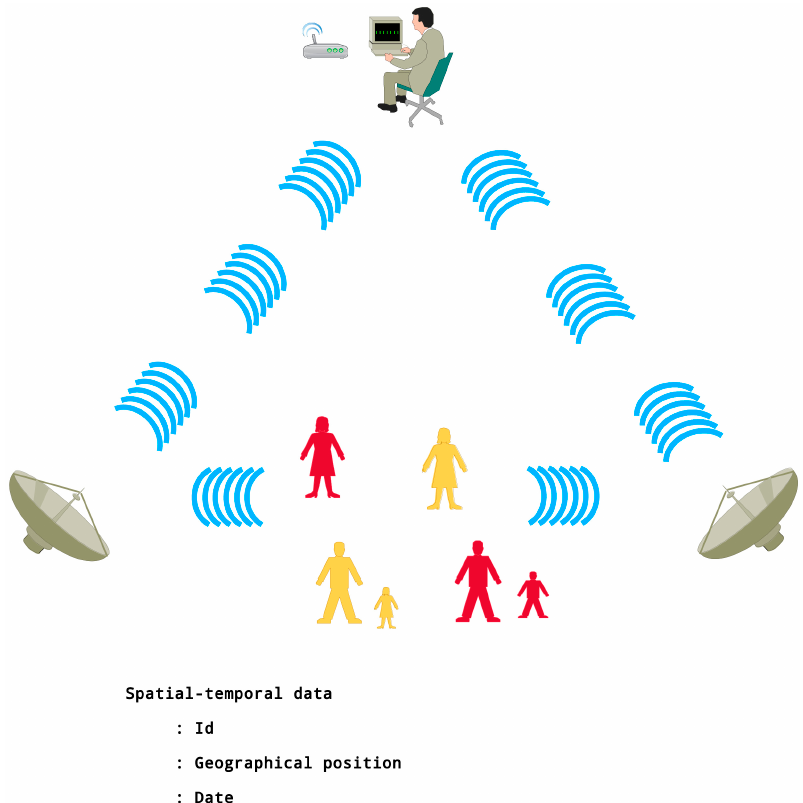
Figure 1. Monitoring collection options.